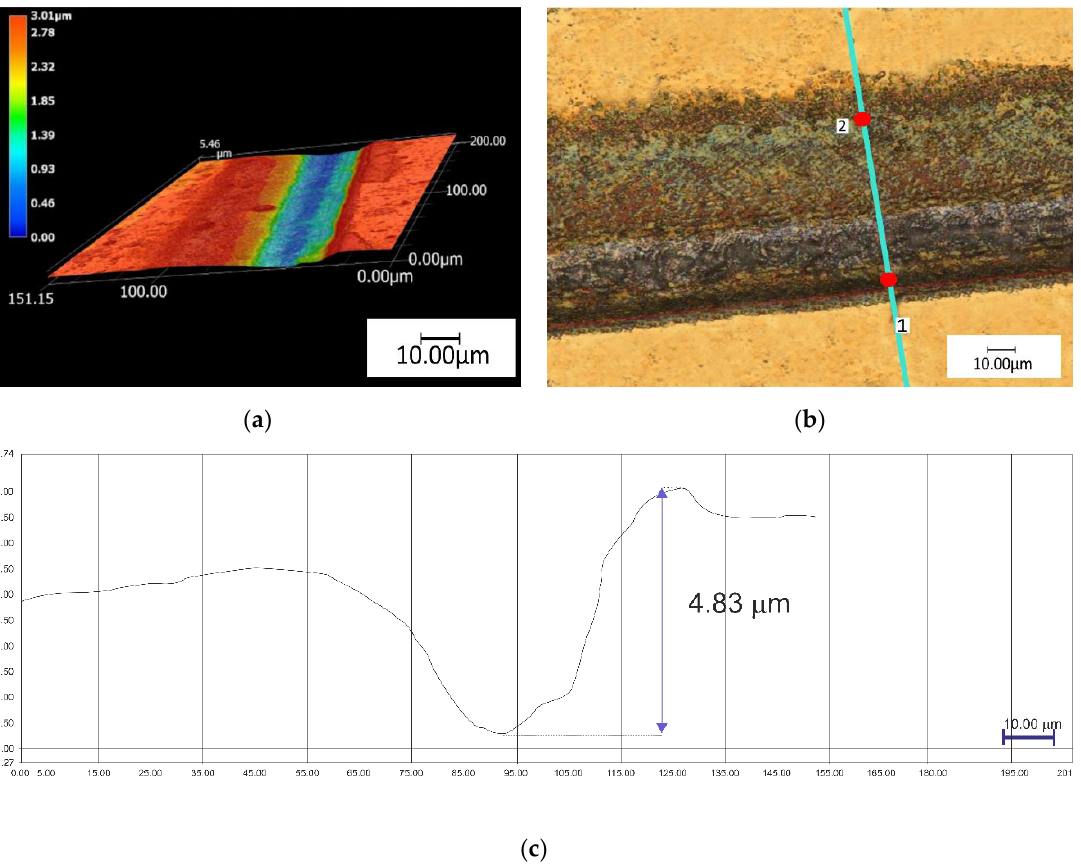
Figure 6. The results of digital microscopy observation for the sample group M5: ( a ) 3D visualization of a single path; ( b ) single track with an indication of the depth measurement location; ( c ) groove depth measurements.